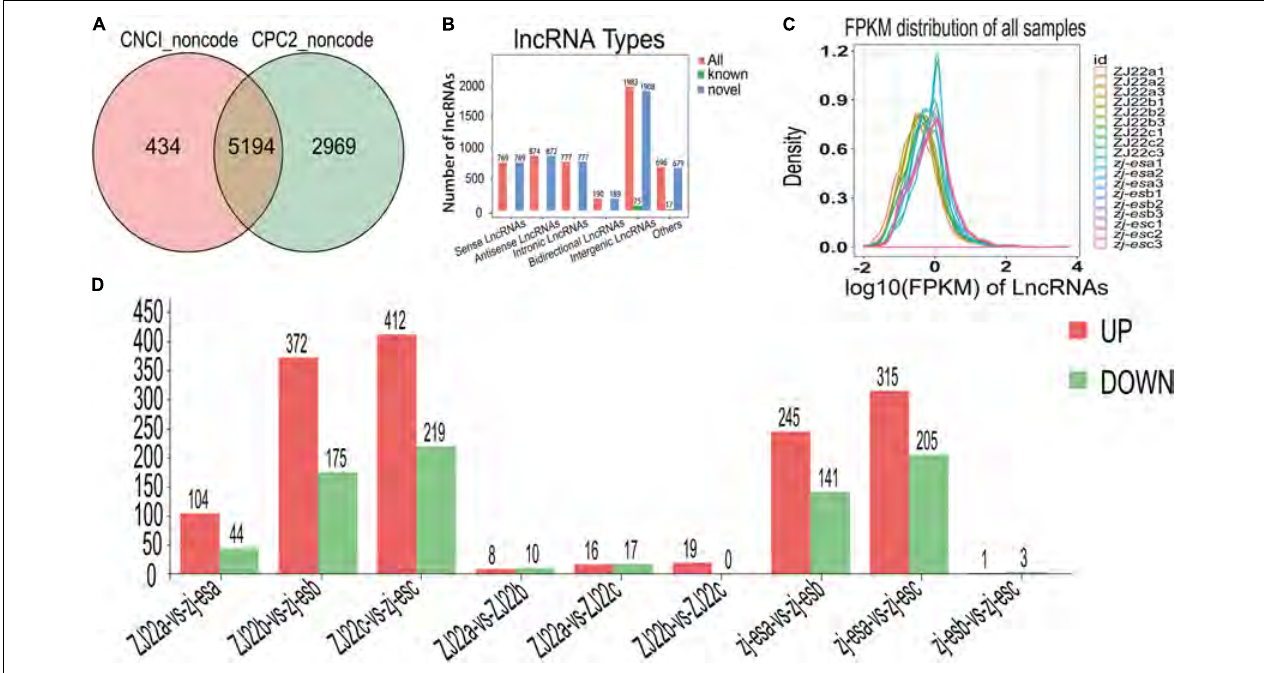
FIGURE 4 | Identification of differentially expressed lncRNAs (DElncRNAs). (A) Venn diagrams of coding potential of lncRNAs. (B) Types of lncRNAs. (C) An abundance distribution map of lncRNAs. Each color represents a sample. (D) Number of significantly regulated genes of